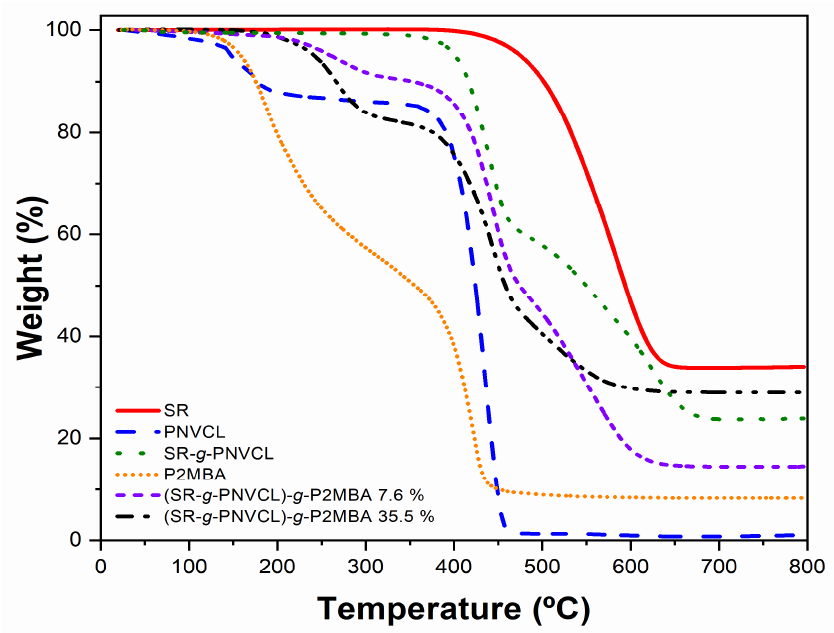
Figure 4. TGA thermograms of SR, PNVCL, SR- g -PNVCL, P2MBA, (SR- g -PNVCL)- g -P2MBA 7.6%, and (SR- g -PNVCL)- g - P2MBA